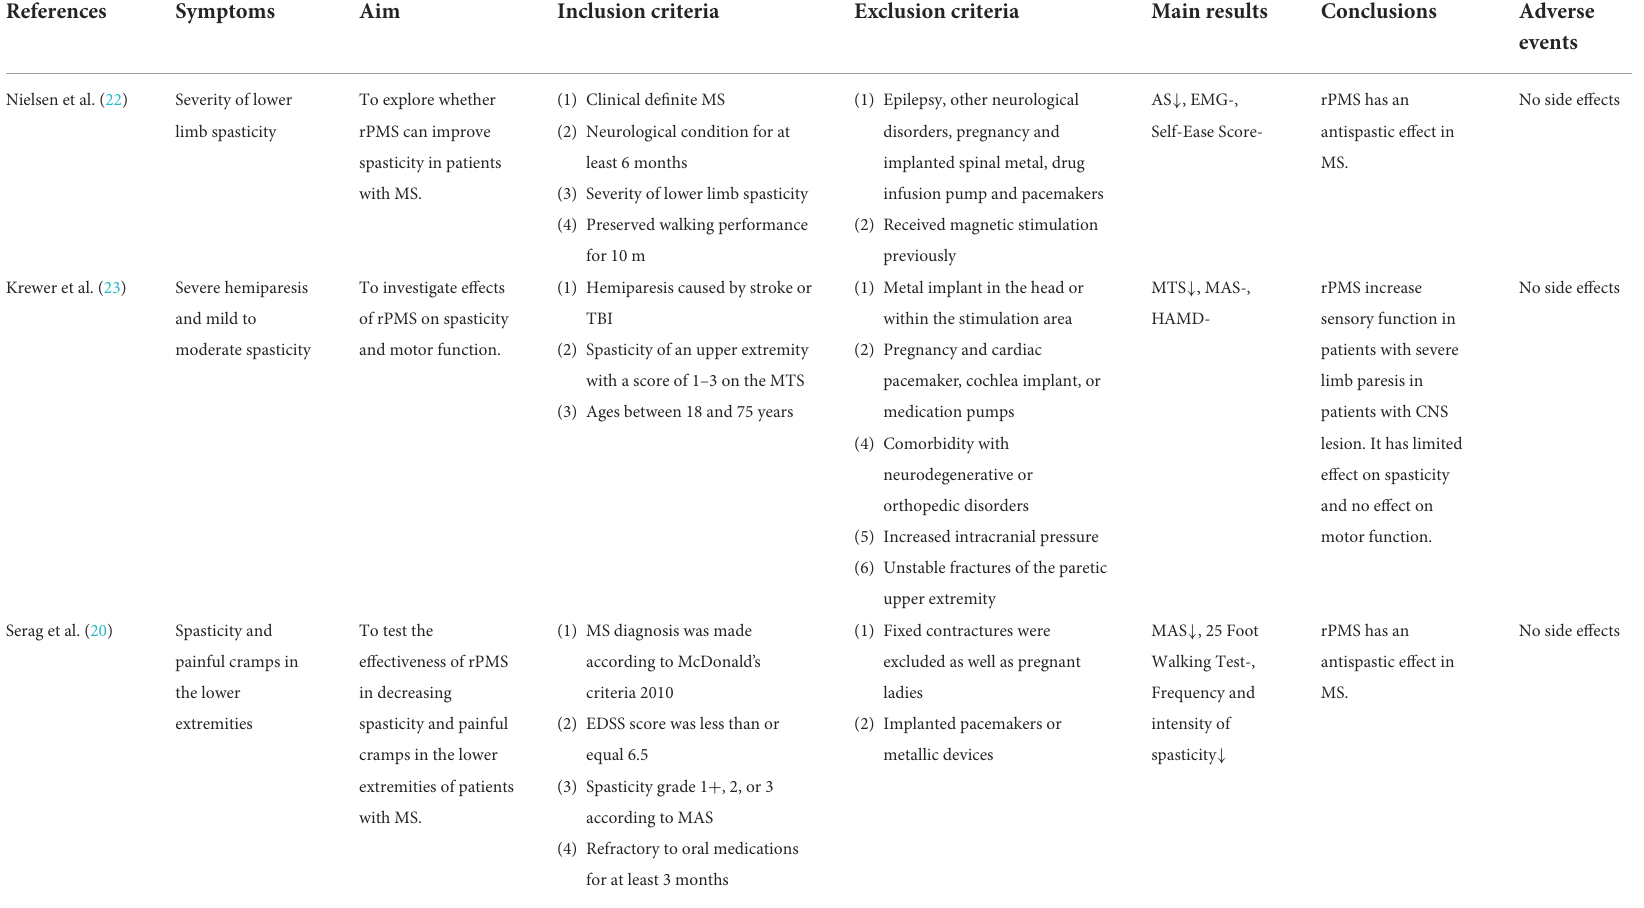
TABLE 3 Aim, main results, and conclusions of included studies for this systematic